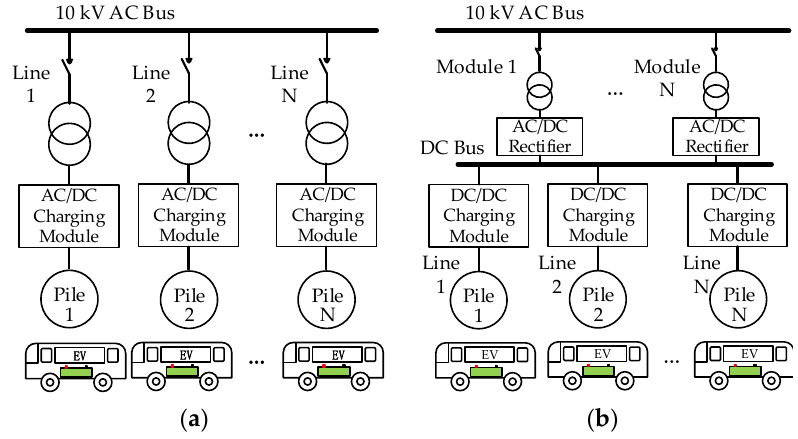
Figure 1. Topologies of two types of fast charging systems. ( a ) Charging system with AC bus (original type); ( b ) Charging system with DC bus (improved type).